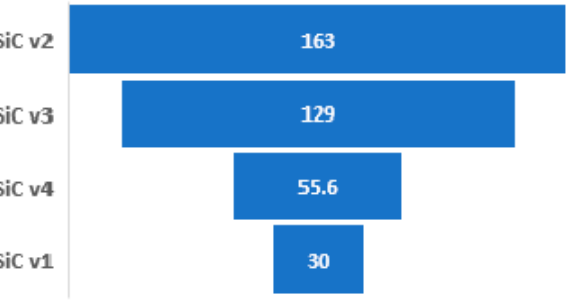
Figure 13. Gate—source voltage rise time for transistor SiC v4 (55 ns).